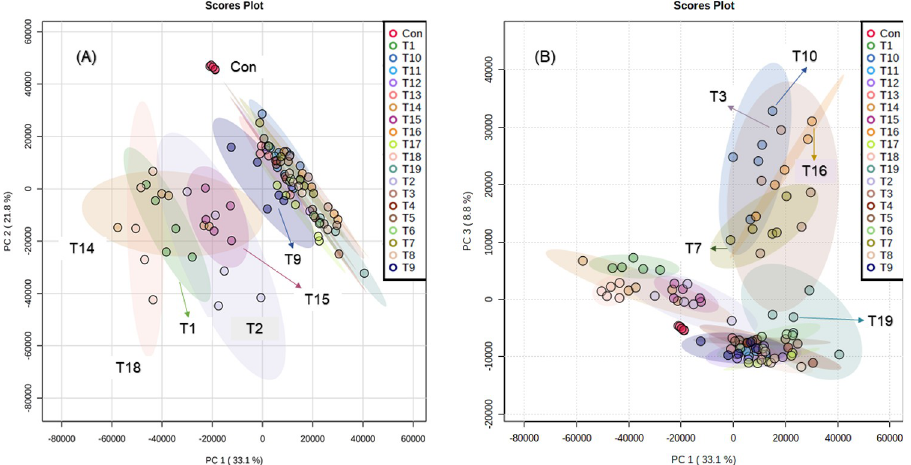
Fig 2. PC1 x PC2 (A) and PC1 x PC3 (B) score plots of metabolic fingerprints of Trichoderma spp. cultures generated using MetaboAnalyst, where Con = Control, UFPIT01 = T1, UFPIT02 = T2, UFPIT03 = T3, UFPIT04 = T4, UFPIT05 = T5, UFPIT06 = T6, UFPIT07 = T7, UFPIT08 = T8, UFPIT09 = T9, UFPIT10 = T10, UFPIT11 = T11, UFPIT12 = T12, UFPIT13 = T13, UFPIT14 = T14, UFPIT15 = T15, UFPIT16 = T16, UFPIT17 = T17, UFPIT18 = T18, and UFPIT19 =